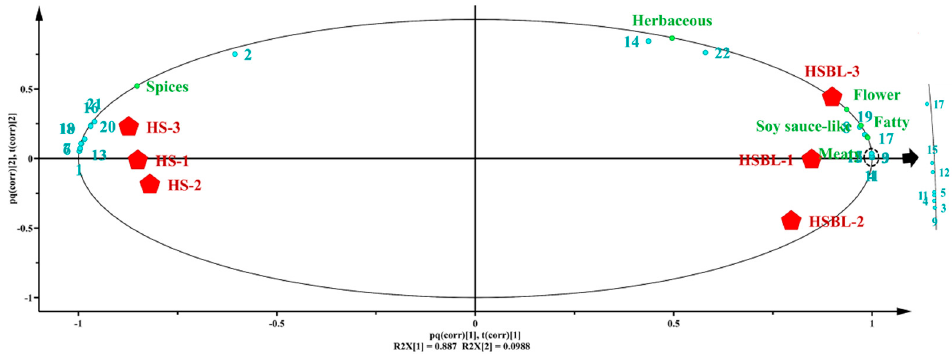
Figure 3. The correlation between sensory properties and important key aroma-active compounds by O2PLS modeling before and after boiling of Hotpot seasoning. by O2PLS modeling before and after boiling of Hotpot